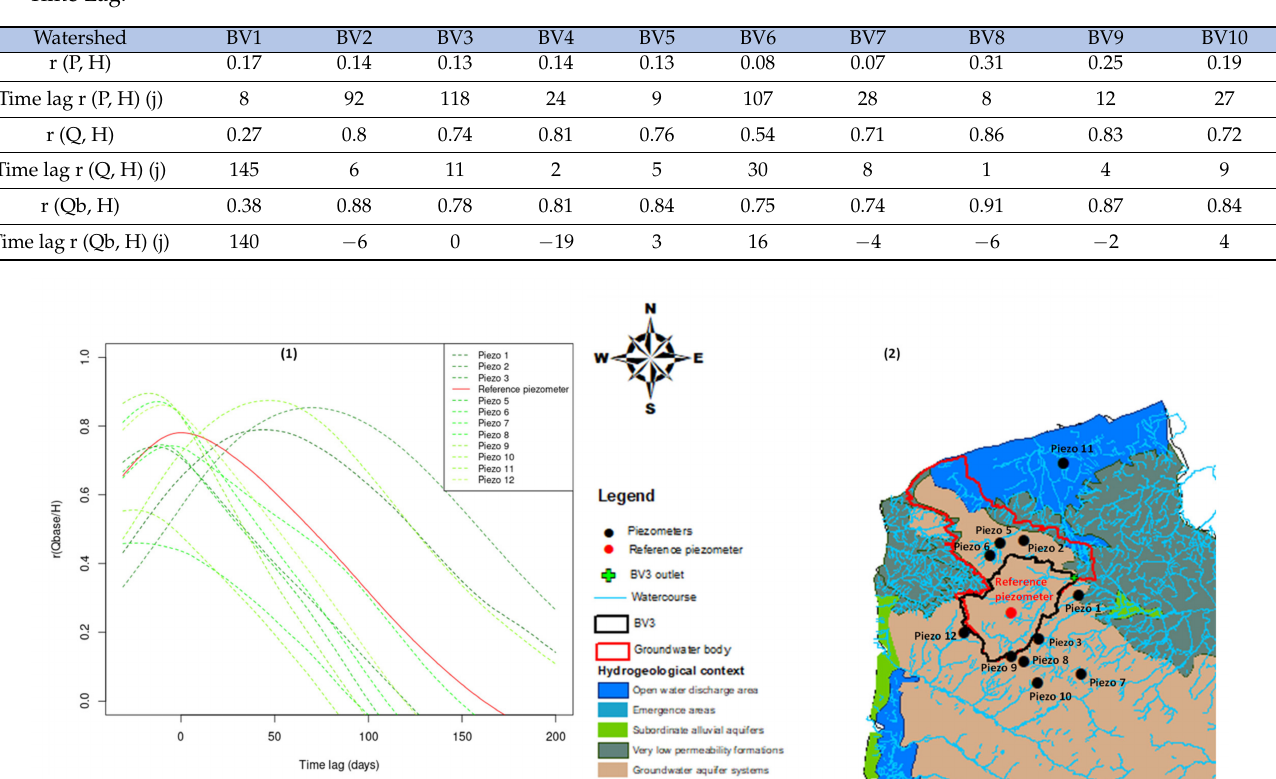
Table 2. Summary of Correlation Values r (P, H), r (Q, H) and r (Qb, H) for the Ten Study Watersheds and Associated Time Lag.